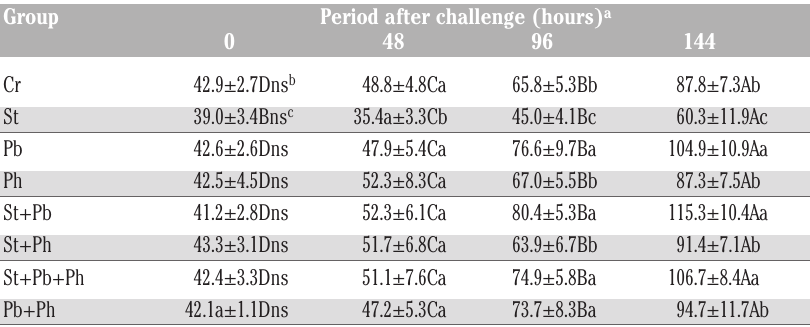
Table 3. Mean of body weight of birds challenged against Salmonella Typhimurium and treated with probiotic and bacteriophage P22. Results are expressed in grams